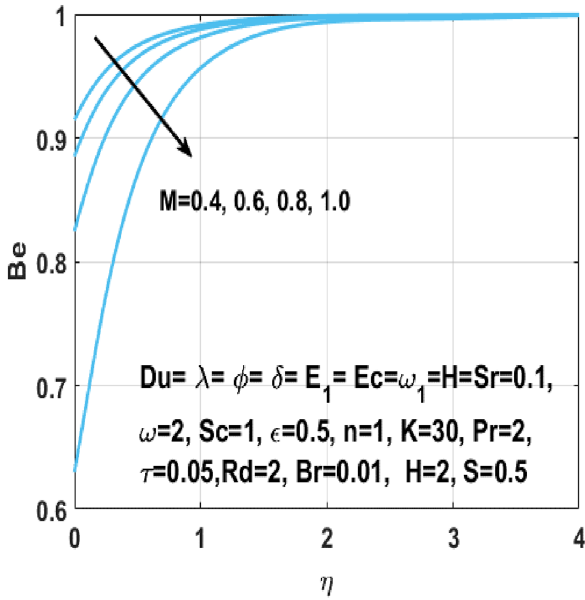
Figure 22. Impact of M on Be .